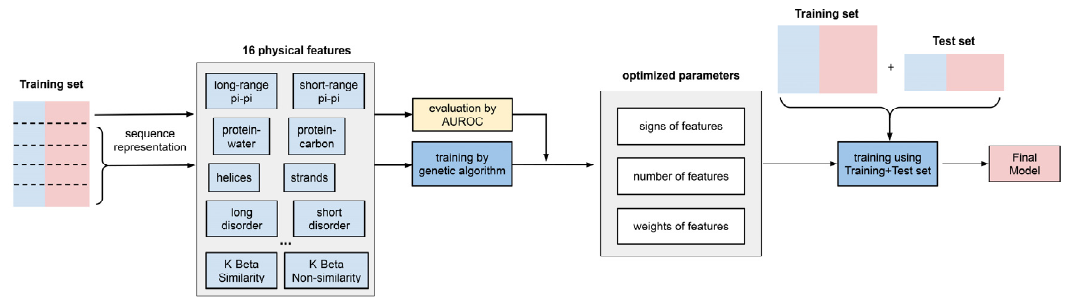
Figure 3. Predictor training workflow. A schematic diagram of the steps in training is